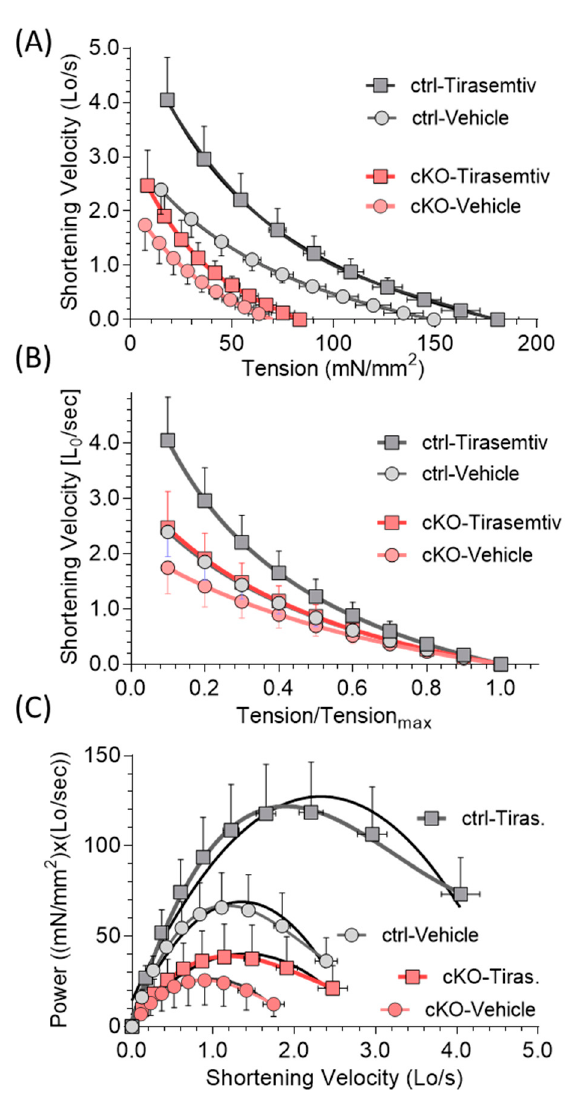
Figure 4. Effect of tirasemtiv on tension-velocity relation and power-velocity relations of diaphragm in control (ctrl) and Neb cKO mice. ( A ) Tension-velocity relationship measured in load-clamp experiments. At all load levels and in both genotypes, tirasemtiv significantly increases shortening velocity ( p < 0.0001). ( B ) Tension-velocity relation with tension normalized to maximal tetanic tension. Tirasemtiv increases the shortening velocity at each tension level in both genotypes and statistical significance was found at Tension/Tension max of 0.1–0.7 for ctrl and 0.1–0.6 for cKO ( p < 0.01). Shortening velocity in cKO with tirasemtiv overlaps with that of ctrl in vehicle. ( C ) Power–velocity relationship. In both genotypes, maximal power is significantly increased by tirasemtiv ( p < 0.0001) and maximal power occurs at higher shortening speeds. (Shortening speed expressed as Lo (length at optimal force)/second). Results from 11 ctrl mice and 13 cKO mice. Mean ± SD are shown. Note that at many frequencies SD lines fall within the symbols.